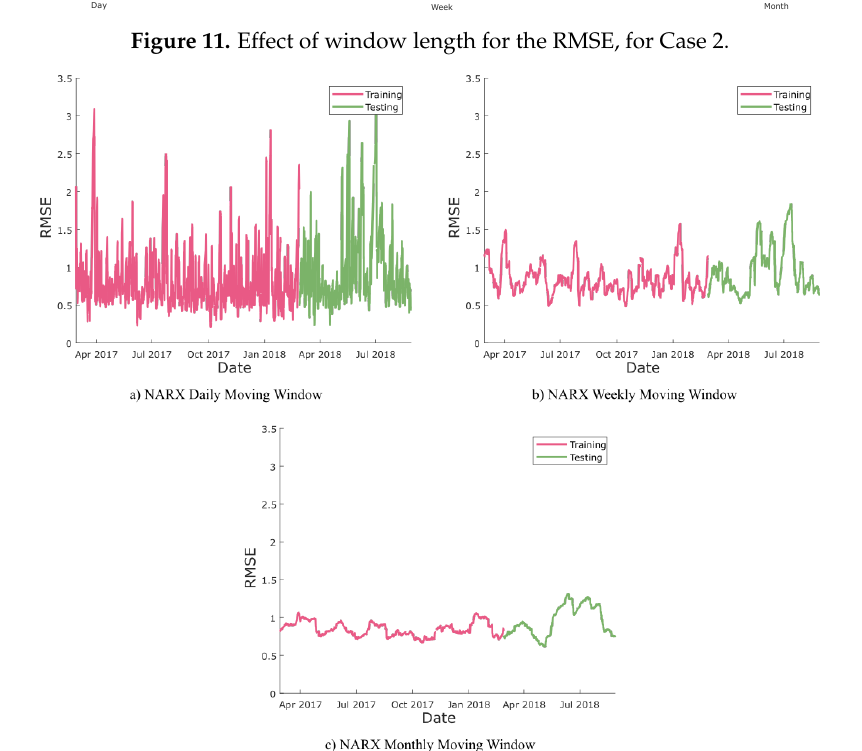
Figure 11. Effect of window length for the RMSE, for Case 2.